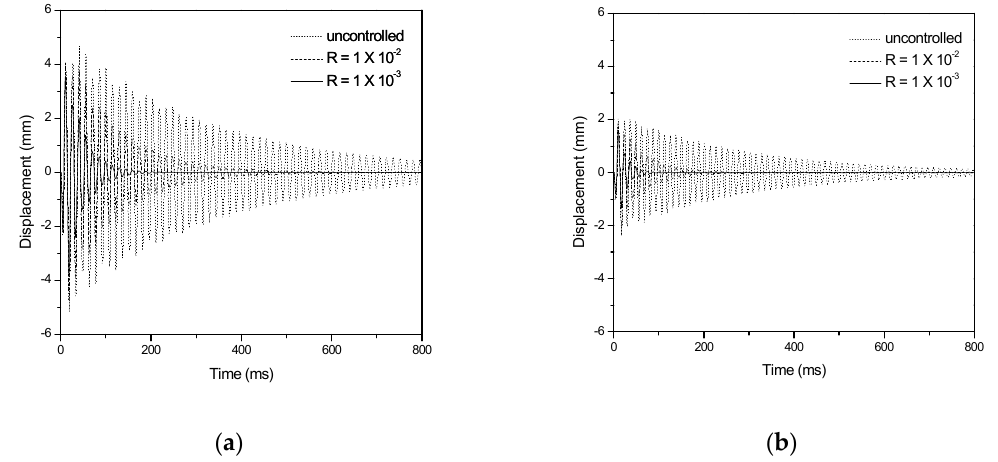
Figure 8. Vertical displacement responses with two locations of stiffener using LQR control: ( a ) Stiffener Case 1; ( b ) Stiffener Case 2.